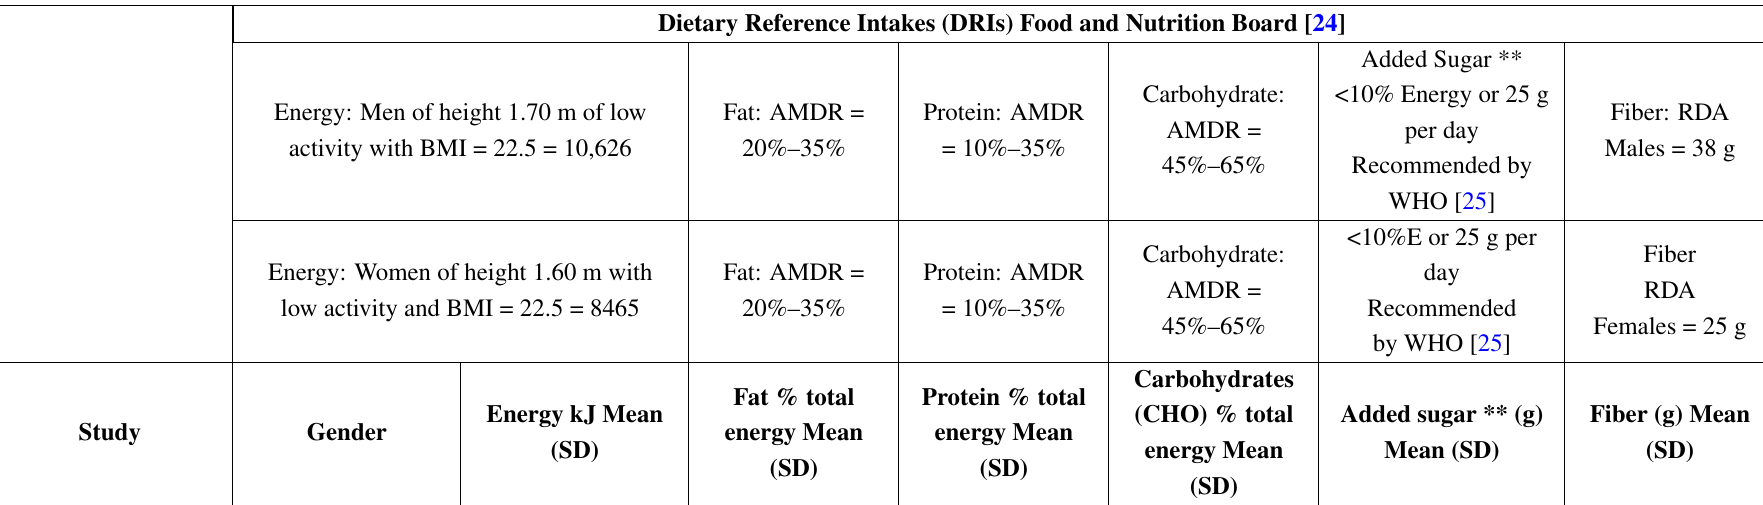
Table 3. Macronutrient intake of South Africans based on the second dietary analysis of studies undertaken after